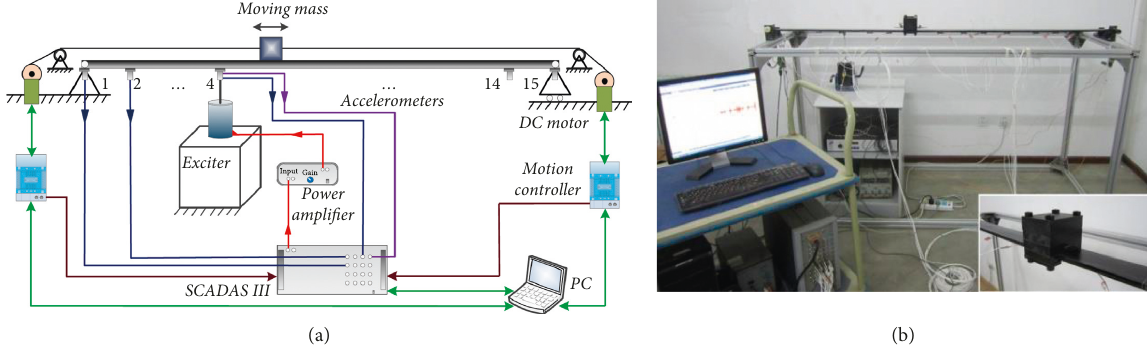
Figure 6: Schematic diagram of the experimental system and photo of its setup.